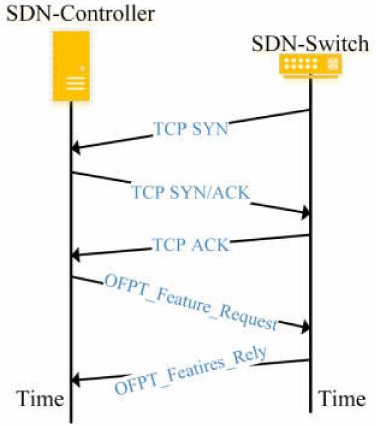
Figure 3. Creating the SDN-Switch discovery process. After the process of establishing OpenFlow SDN-Switch connection, flow tables will contain the SDN-Switch header information and actions (responsible for giving